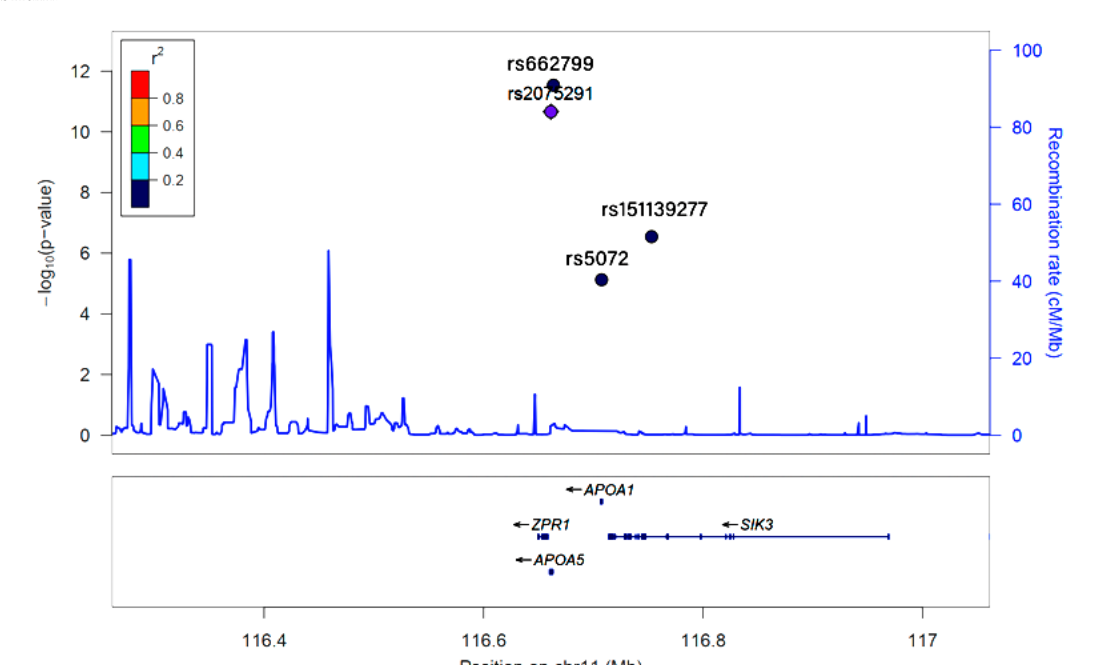
a Chromosome; b Single nucleotide polymorphism; c Minor allele of haplotype; d Major allele of haplotype; e Odds ratio of each SNP J. Pers. Med. 2021 , 11 , x FOR PEER REVIEW for 3GO risk; f p- value for ORs after adjusting for age, gender, residence area, and BMI; g Minor allele frequency; h Hardy–Weinberg equilibrium.